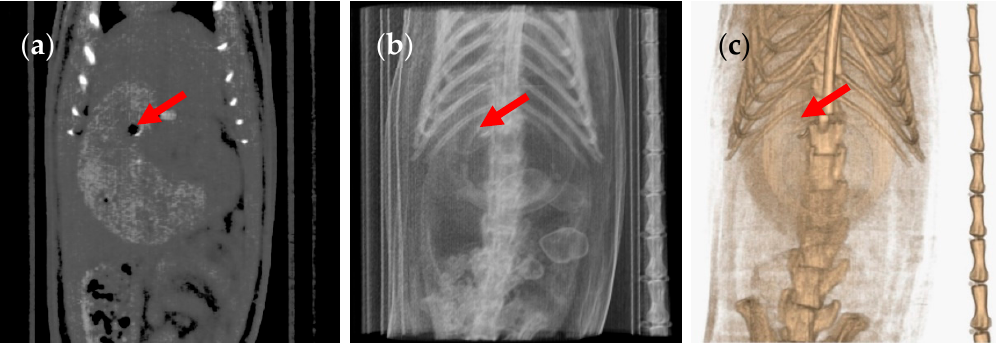
Figure 6. ( a ) Coronal CT slice of an animal with a broken size 9 capsule in the stomach 6 h after administration. The white trail of spots left by the broken capsule is signalled by a red arrow. ( b ) Planar CT projection and ( c ) three-dimensional rendered CT image of the same animal. This animal did not receive anaesthesia.